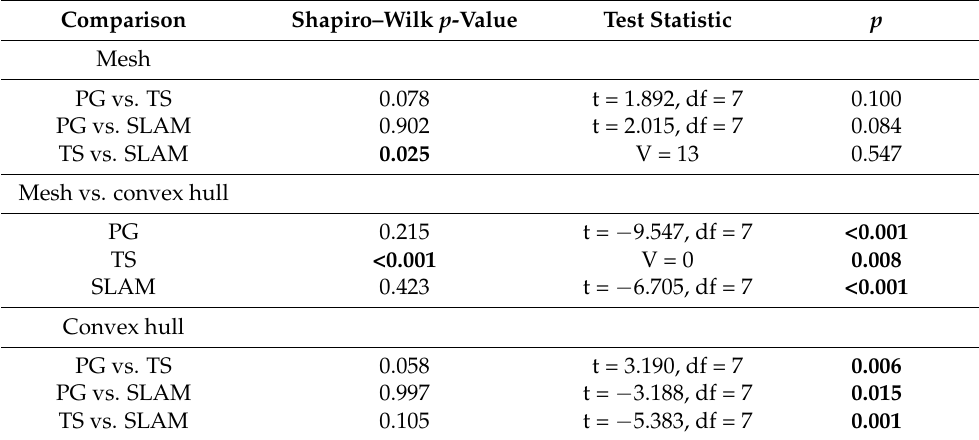
Table 3. Wilcoxon signed-ranks tests for differences in mesh and convex hull surface areas. Bold values are significant at α =